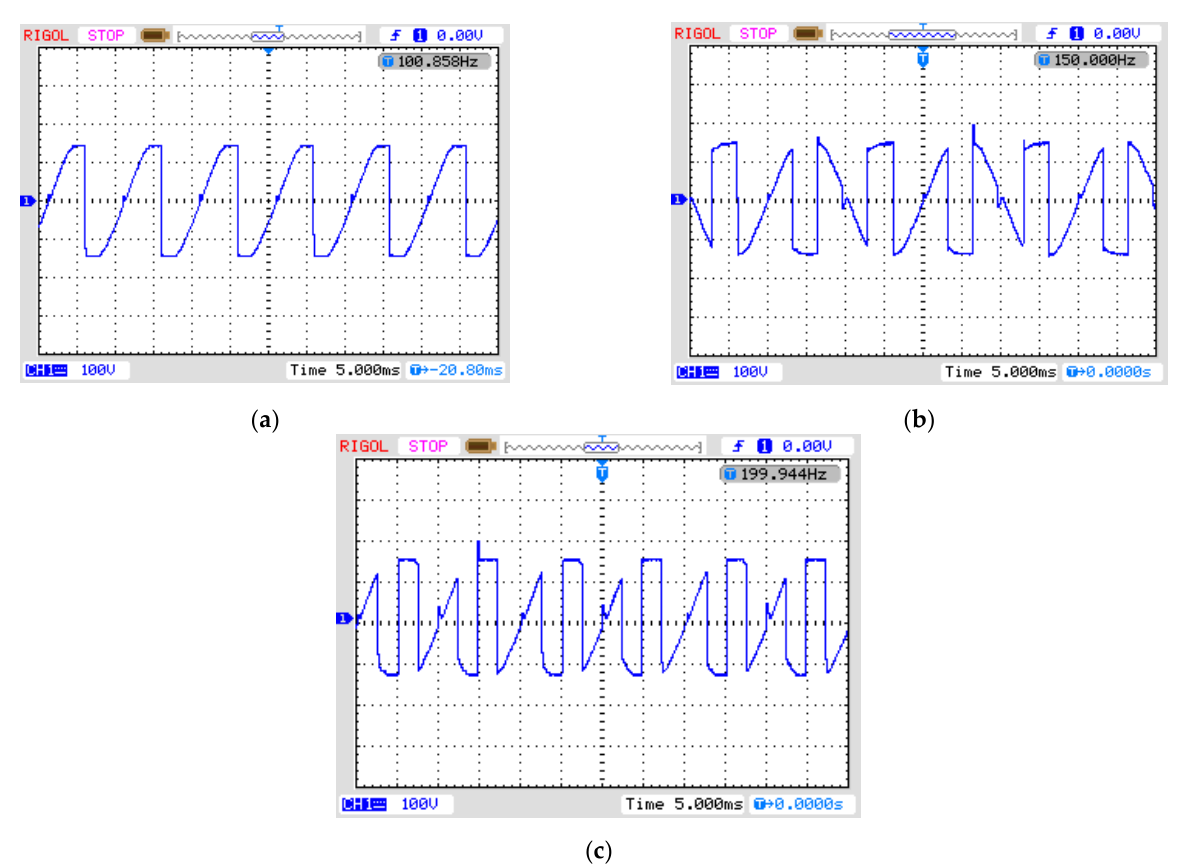
Figure 19. Stepping up of standard frequency (50 Hz) at the output to ( a ) 2(50) Hz; ( b ) 3(50) Hz; ( c ) 4(50)